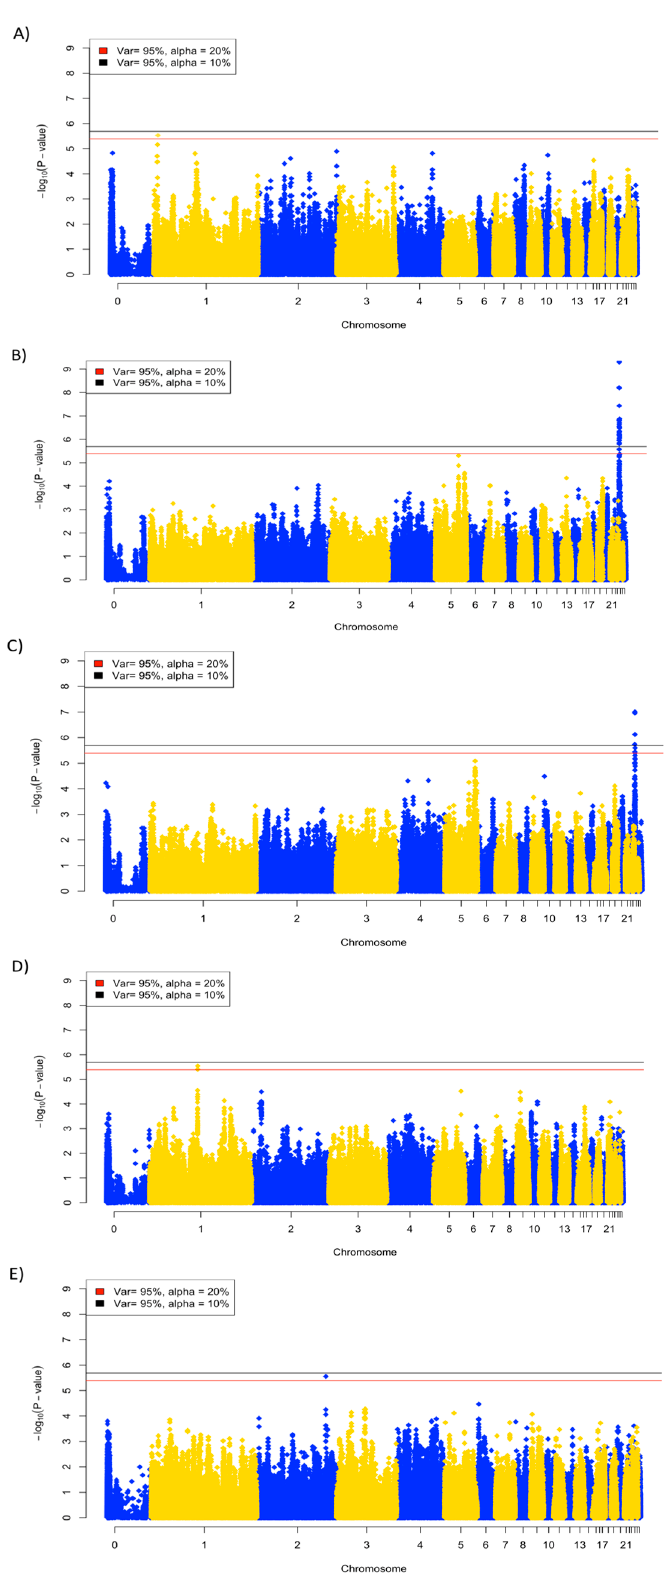
Figure 3. Manhattan plots of the genome-wide association analysis of traits, with suggestive SNPs at the 10 (black) and 20% (red) genome-wide significance: ( A ) viral titer at 2 dpi; ( B ) viral titer at 6 dpi; ( C ) viral clearance; ( D ) log 10 anti-NDV antibody S/P ratio at 10 dpi, and ( E ) day 13 body weight change.